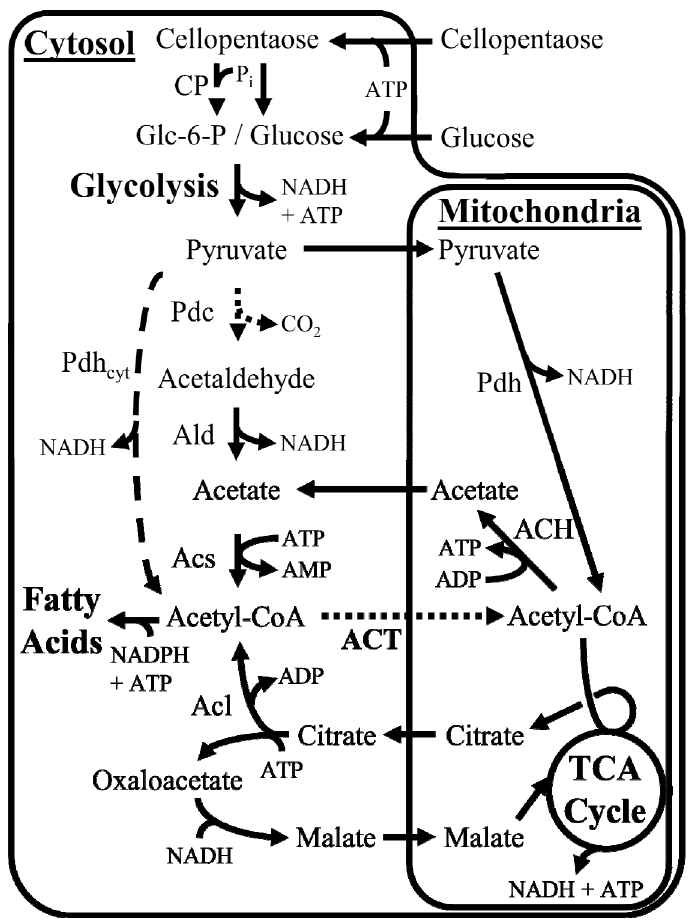
Figure 1. Overview of fungal acetyl-CoA metabolism. Common acetyl-CoA pathways in fungi are shown in solid arrows. A cytosolic pyruvate dehydrogenase (heavy dashed line) may increase functionalized hydrocarbon production but was not found in fungi and was not annotated in As-